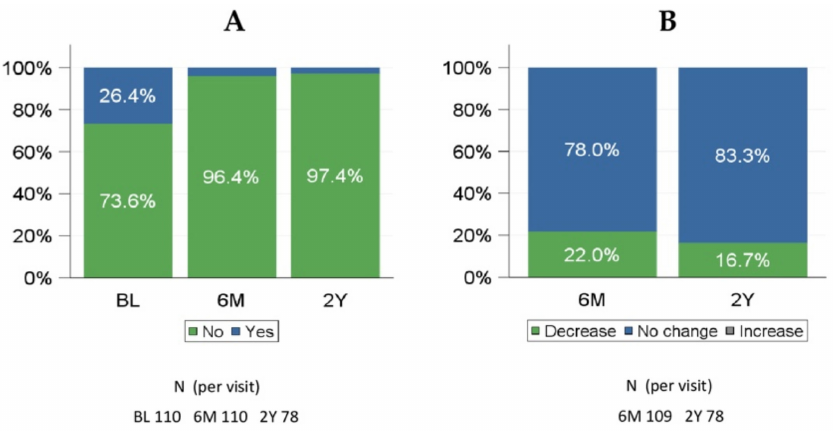
Figure 2. Hemolysis-related blood transfusions at baseline, 6 months, and 2 years (FAS). ( A ) any hemolysis-related blood transfusion given; ( B ) qualitative change from baseline in hemolysis-related transfusions. 6M: 6 months; 2Y: 2 years. FAS = full analysis set.